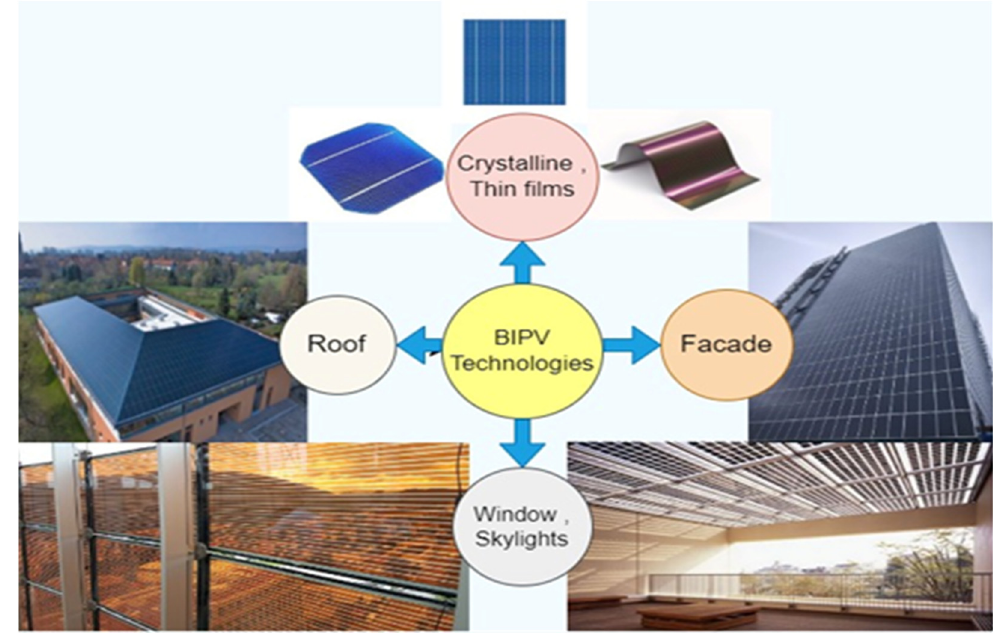
Figure 1. Categorization of BIPV system.